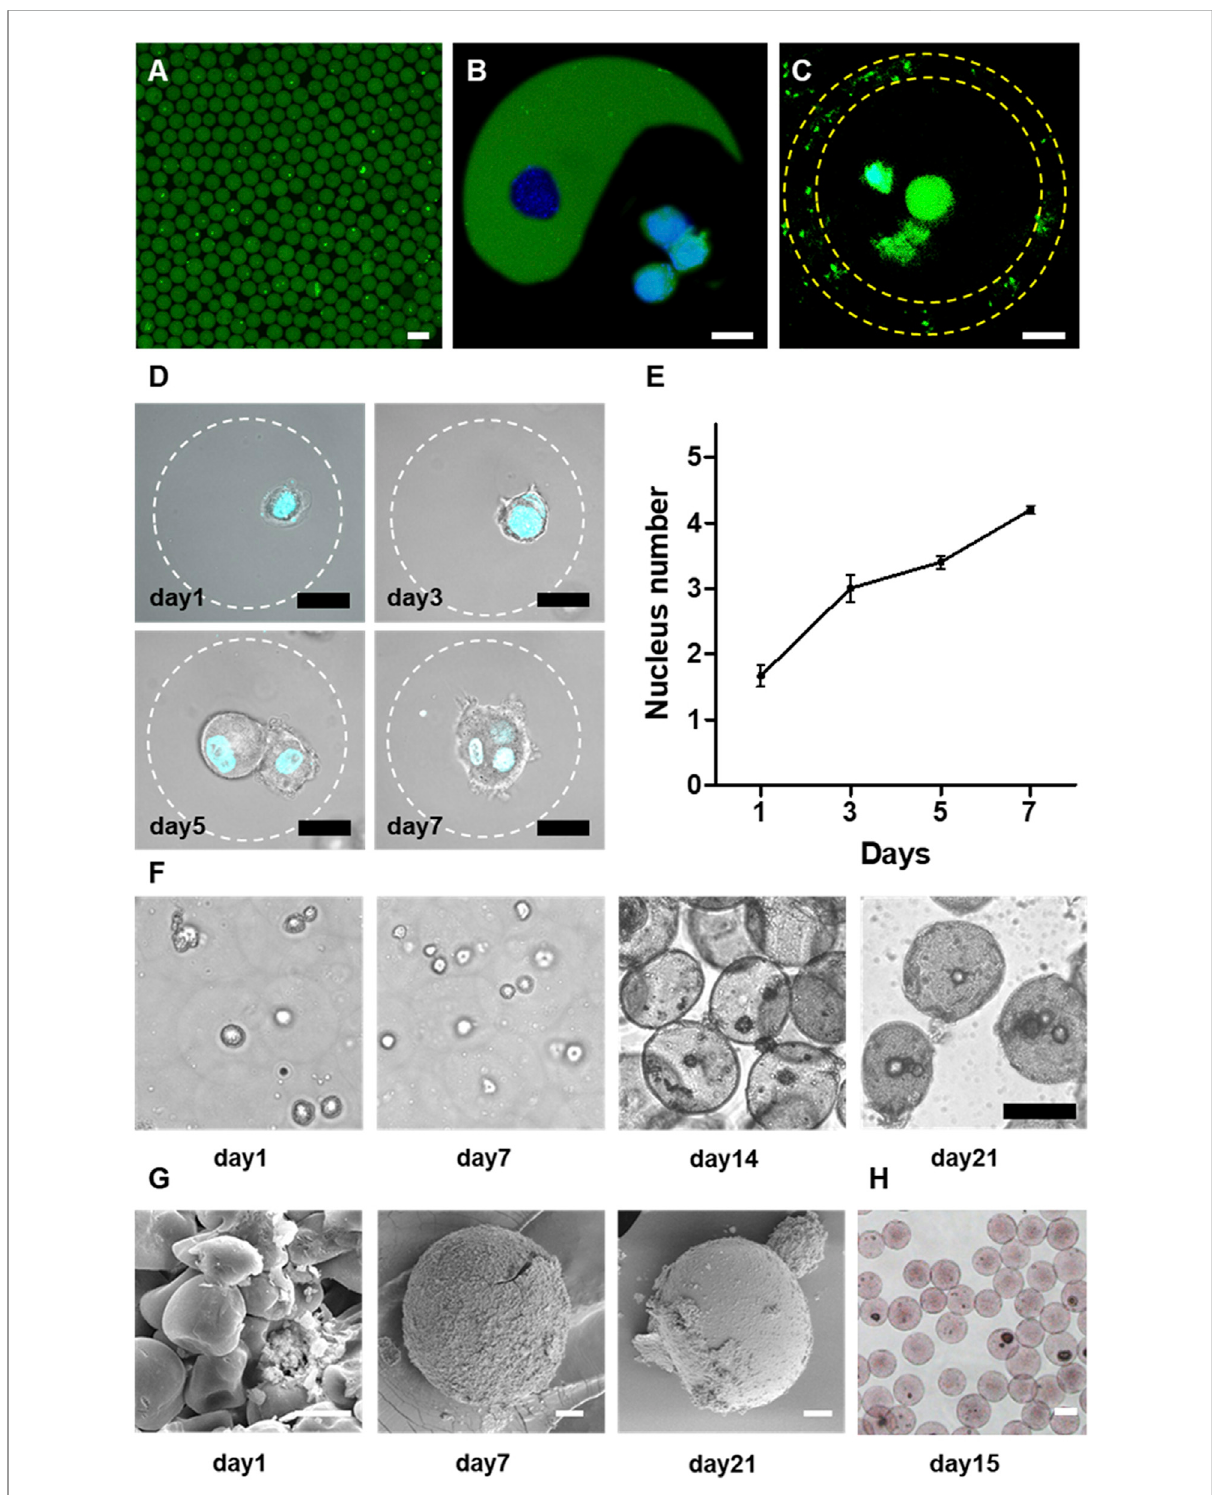
FIGURE 4 One-step micro fl uidic approach for large-scale generation of cell-laden microgels. (A) The representative confocal microscopic image of the rat bone marrow stromal cells (MSCs) encapsulated in alginate microgels. Alginate was labeled by fl uorescein and cells were marked by GFP. Scale bar is 100 μ m., (B,C) The representative confocal microscopic images of rat-MSCs encapsulated in Janus (B) and Core-shell (C) alginate microgels. Scale bars are 20 μ m. (D) The confocal microscopic images of MSCs in the microgels. Cells were stained by DAPI nuclei staining. Cells